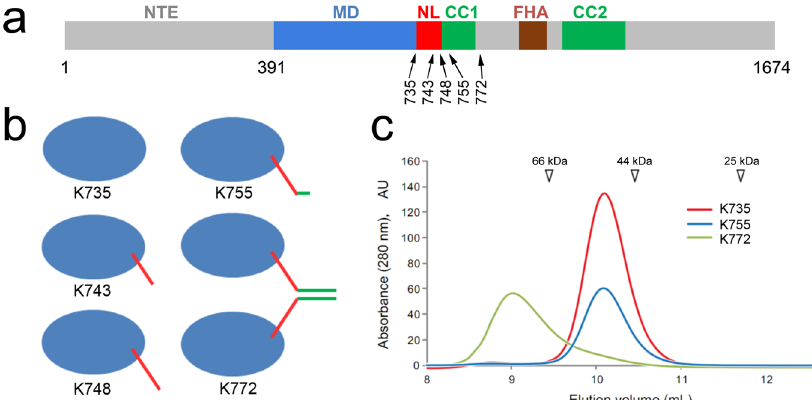
Fig. 1 KIF14 constructs. a Primary structure and domain organization of Mus musculu s KIF14. NTE N-terminal extension, MD motor domain, NL neck-linker domain, FHA Forkhead-associated domain, CC1 coiled coil domain 1, CC2 coiled coil domain 2. Five constructs were used in this work. The constructs include the motor domain from residue 391 at the N-terminal end and up to residues 735, 743, 748, 755, or 772 (relative size of bars and arrow positions not at scale). b Predicted quaternary structure of the KIF14 constructs used. c Size-exclusion chromatography elution pro fi le of constructs K735, K755, and K772. The migration peak positions of protein standards are indicated (Bovine Serum Albumin, 66 kDa; Ovalbumin, 44 kDa; and Chymotrypsin, 25